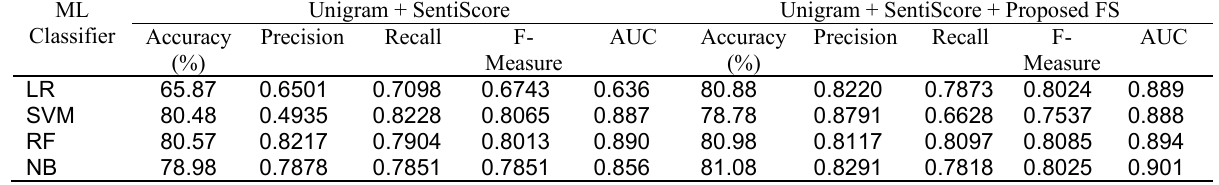
Table 7. Results of the proposed model for Amazon Product review data set